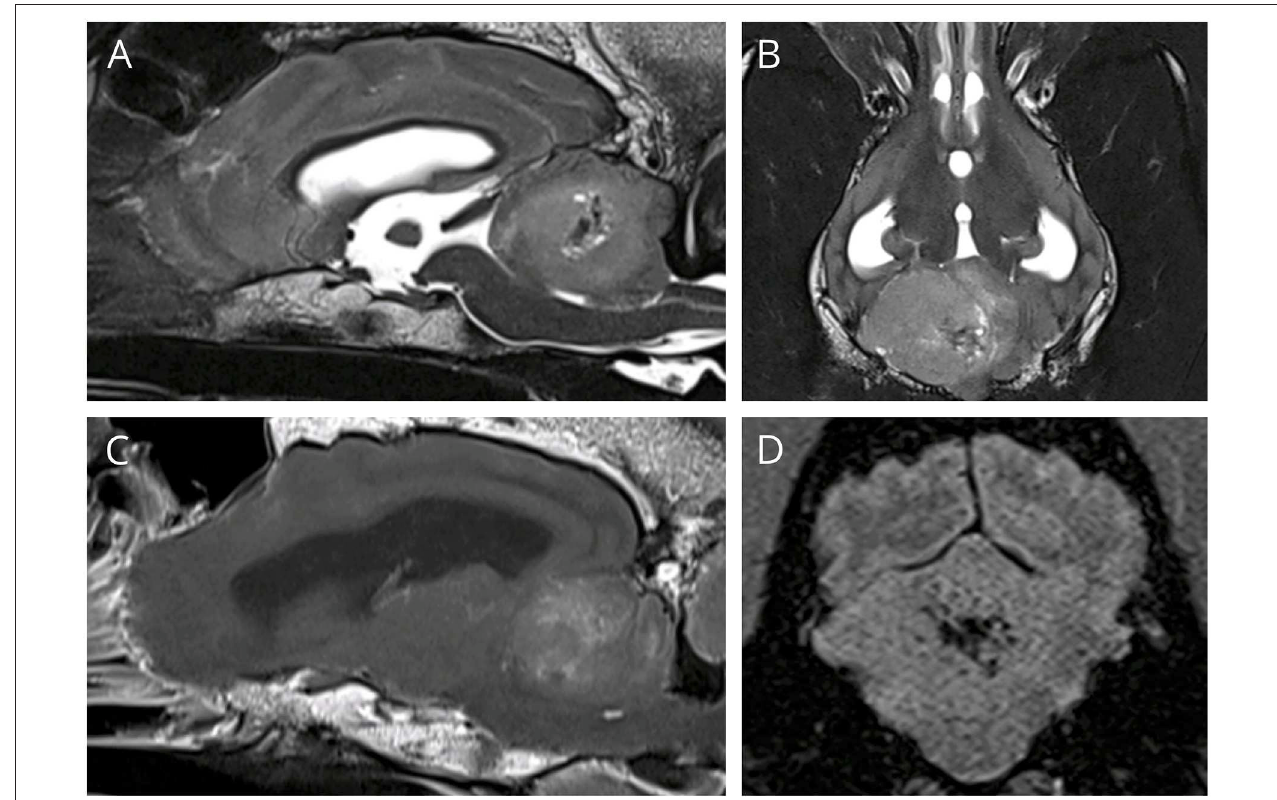
FIGURE 1 | (A,B) T2W sagittal and dorsal, showing a large hyperintense space occupying mass in the cerebellum. (C) T1 post contrast sagittal, showing mild heterogeneous contrast enhancement, especially at the rim, (D) SWI transverse showing signal drop out centrally, consistent with